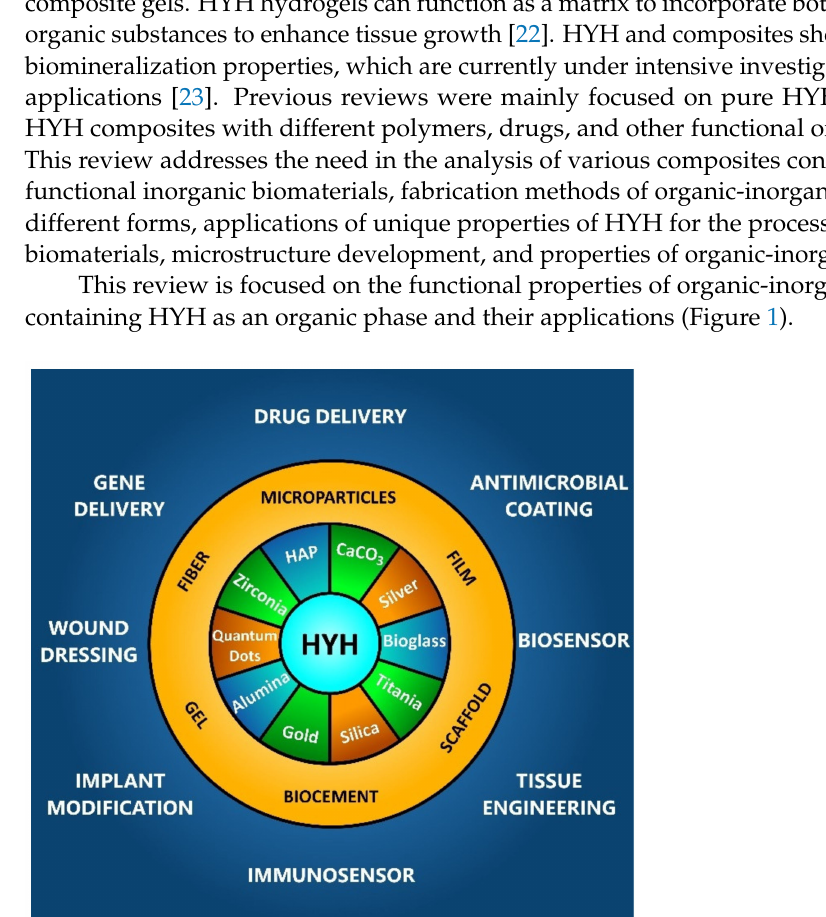
Figure 1. HYH-based organic-inorganic composites and their biomedical